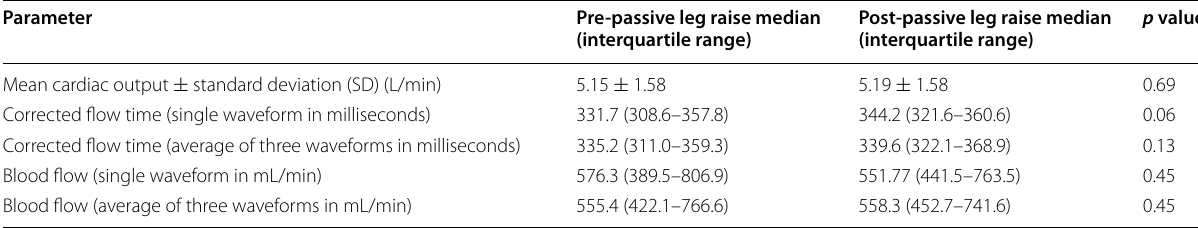
Table 2 Baseline mean cardiac output and median carotid ultrasound parameters (corrected flow time and blood